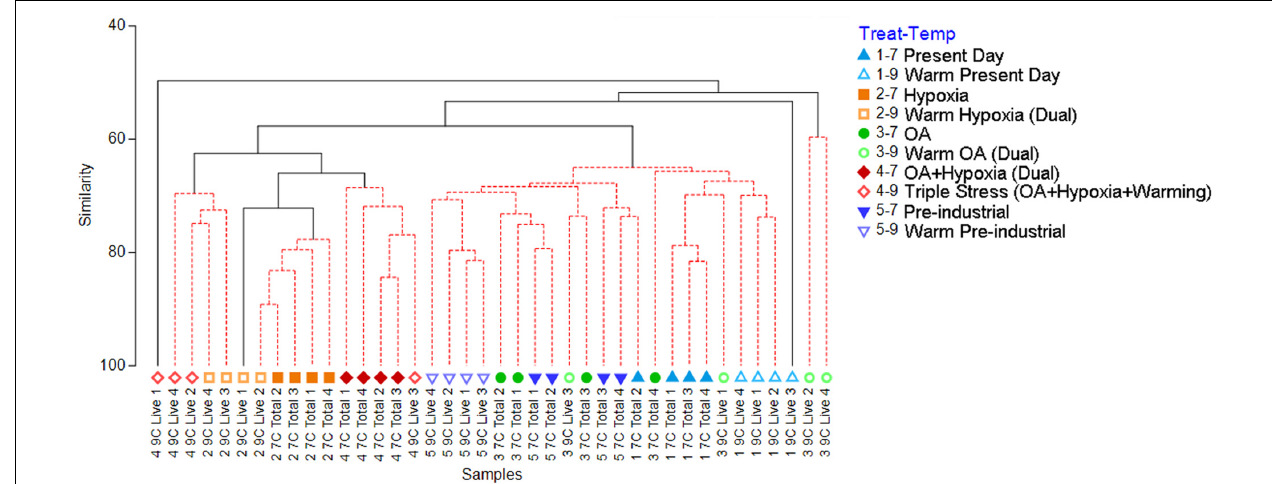
FIGURE 3 | Cluster analysis generated from the Bray-Curtis similarity matrix, which was calculated from square-root transformed abundance data of the 7 ◦ C Total and 9 ◦ C Live counts. The red-dashed portions of branches indicate no significant difference between those connected samples (PRIMER SIMPROF analysis, p < 0.05). Treatment 1 (blue) is Present Day (nominally 7.1 mL/L O 2 , 400 ppmv p CO 2 ); Treatment 2 (orange) is Hypoxia (nominally 0.7 mL/L O 2 , 400 ppmv p CO 2 ); Treatment 3 (green) is OA (nominally 5.9 mL/L O 2 , 2,000 ppmv p CO 2 ); Treatment 4 (red) is OA + Hypoxia (nominally 0.7 mL/L O 2 , 2,000 ppmv p CO 2 ); Treatment 5